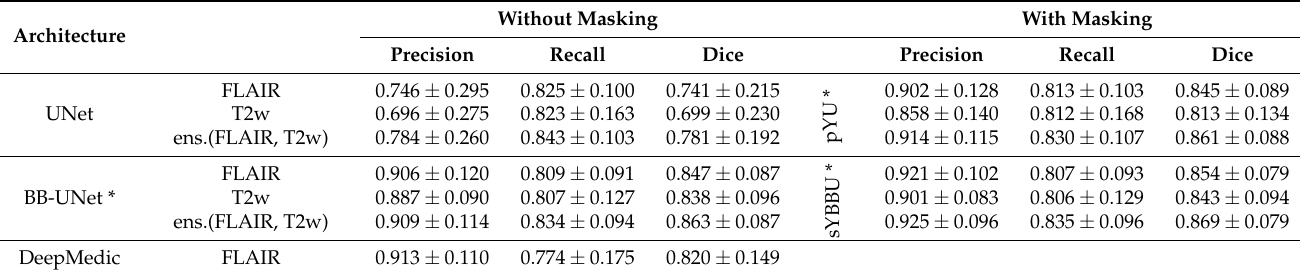
Table 4. Segmentation results on TCGA-GBM test with 97 test patients. Unlike (BB-)UNet approaches, Deepmedic net- work [19] is trained on 3D volumes from the HGG train dataset. Results present the mean ± standard deviation.